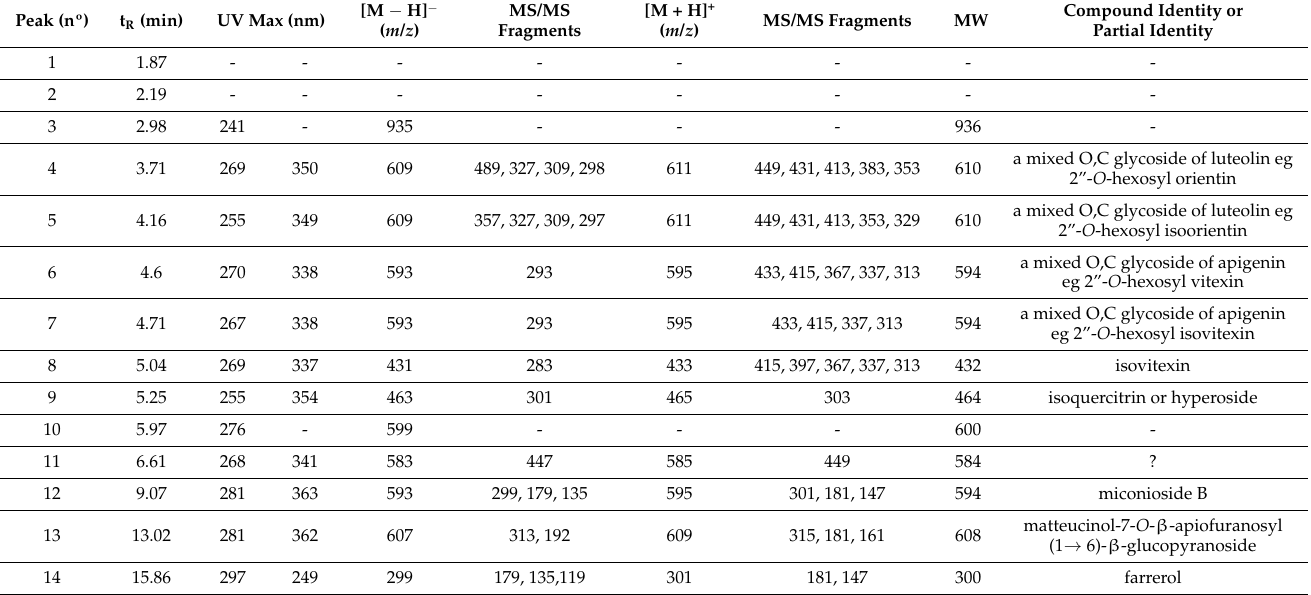
Table 2. Data from UHPLC/UV/MS/MS analysis of M. chamissois Naudin. aqueous leaf